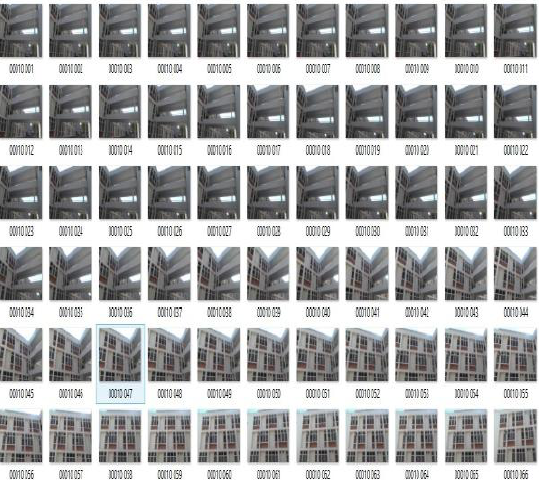
Figure 2: Flow diagram of methodology for data acquisition process